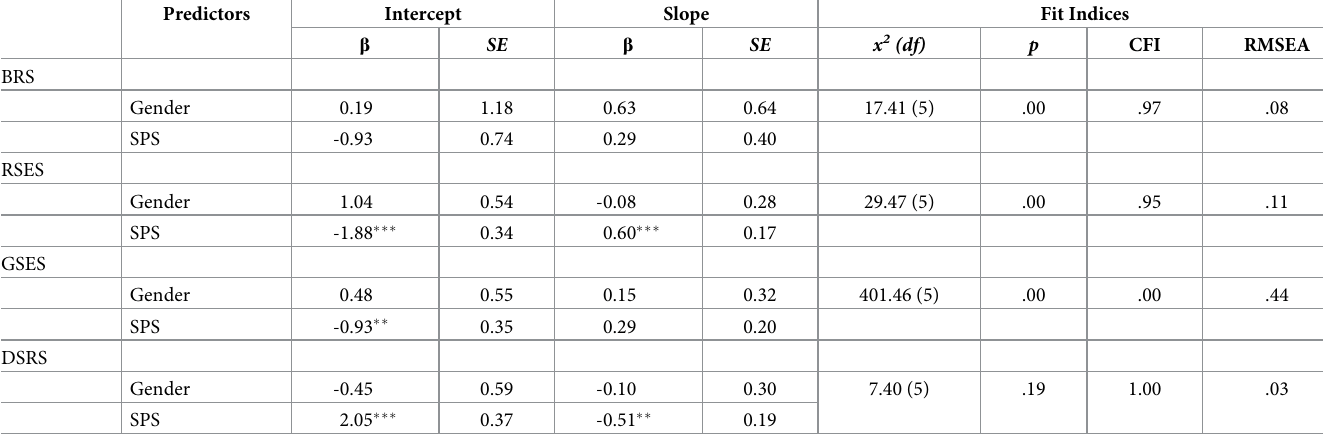
Table 5. Effects of gender and SPS as predictors on efficacy of the intervention in latent growth curve model (LGCM). Predictors